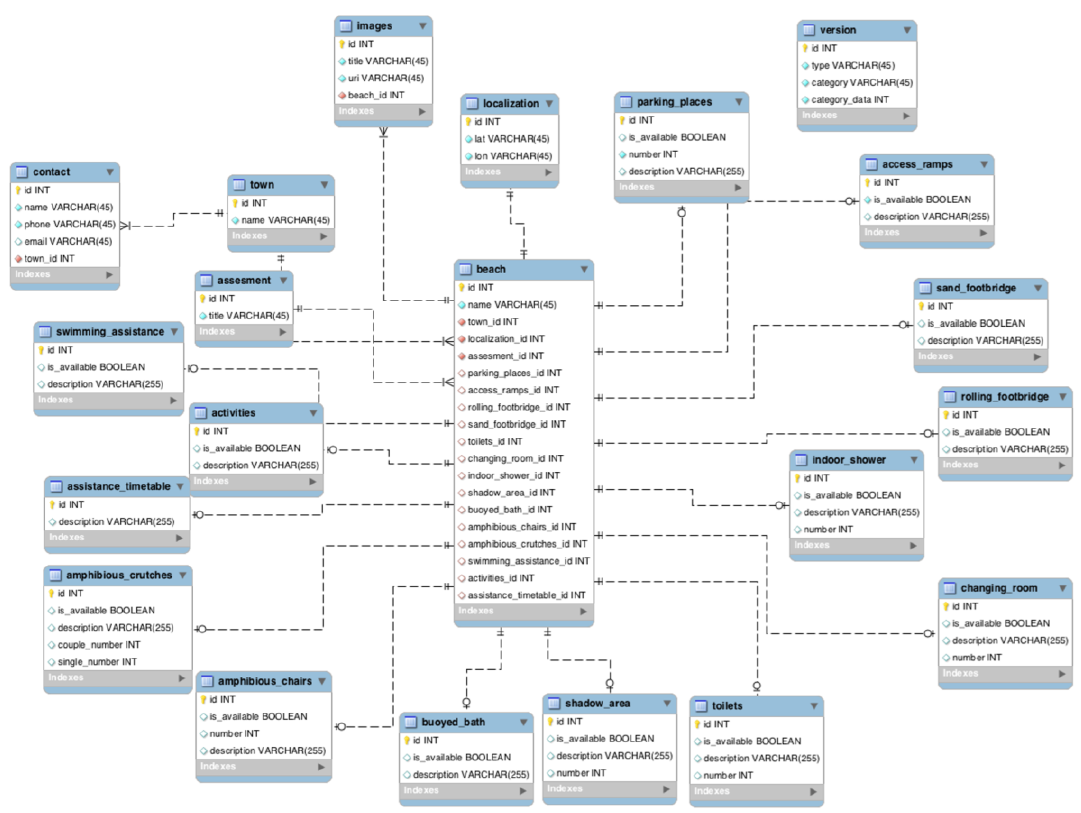
Figure 4. Entity-relationship diagram of the developed system [24].